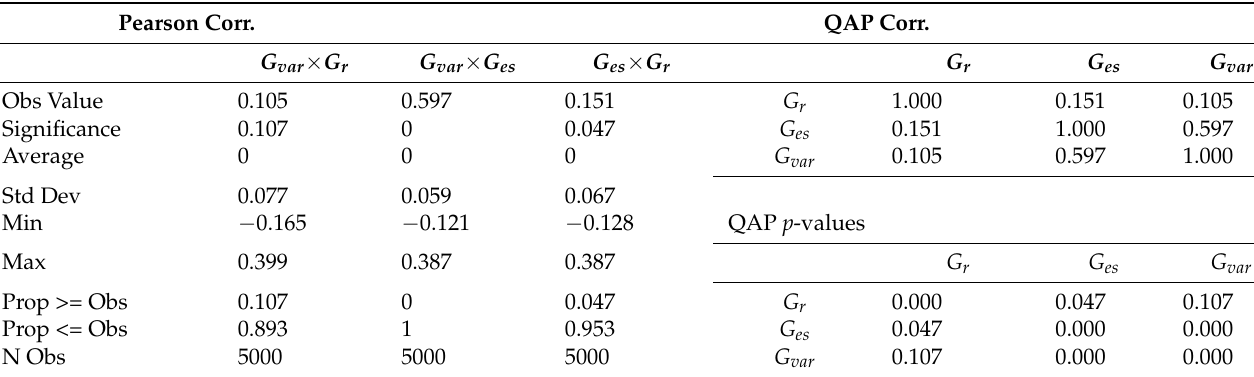
Table 3. QAP Correlation Analysis